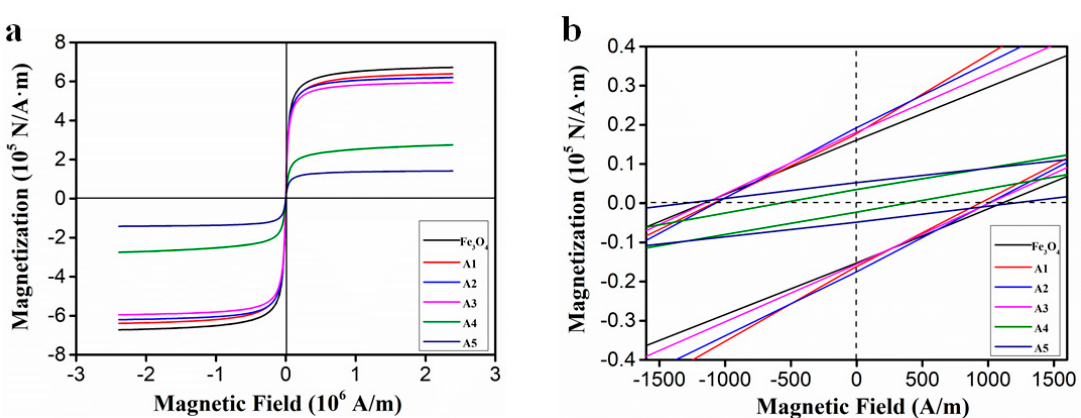
Figure 7. The magnetization curves of Fe 3 O 4 and EG/ Fe 3 O 4 ( a ) and an expanded view of the low-field magnetization curves ( b ).